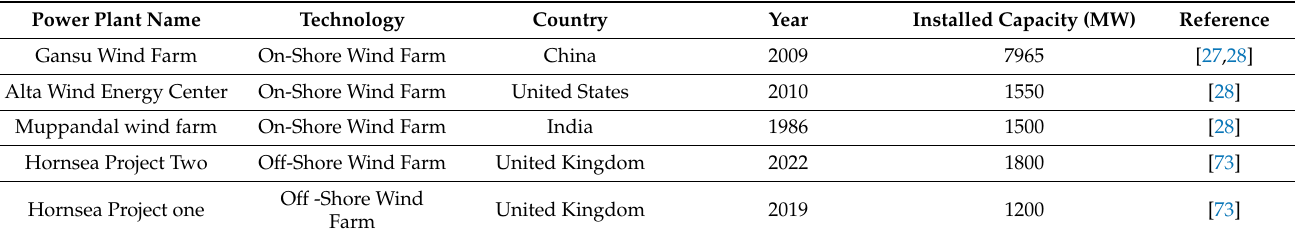
Table 3. Largest wind energy projects around the